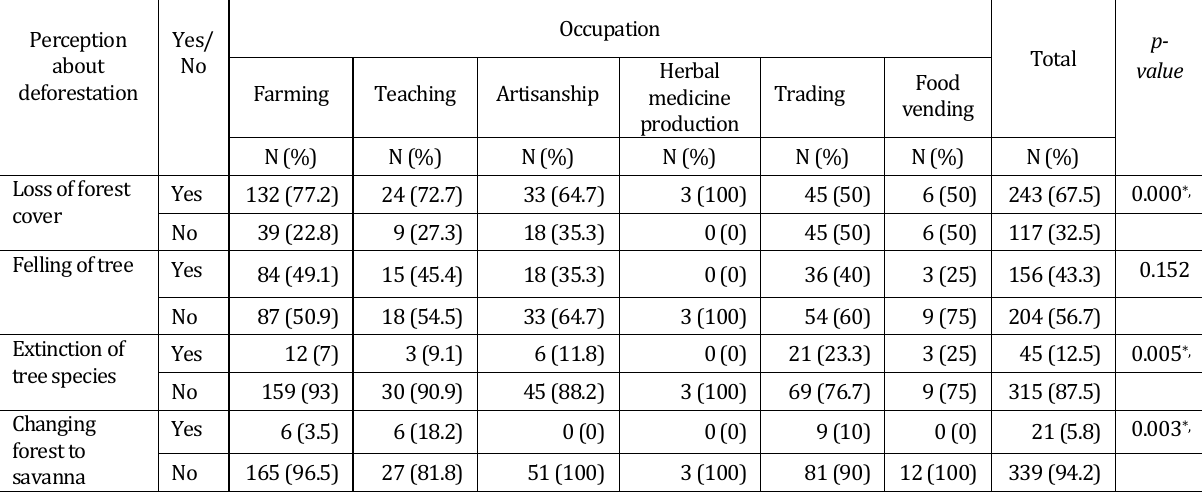
Table 5. Chi-Square test of occupation by perception about